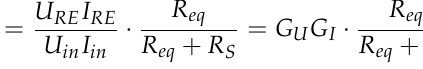
Figure 10. Supercapacitor (SC) charging method.